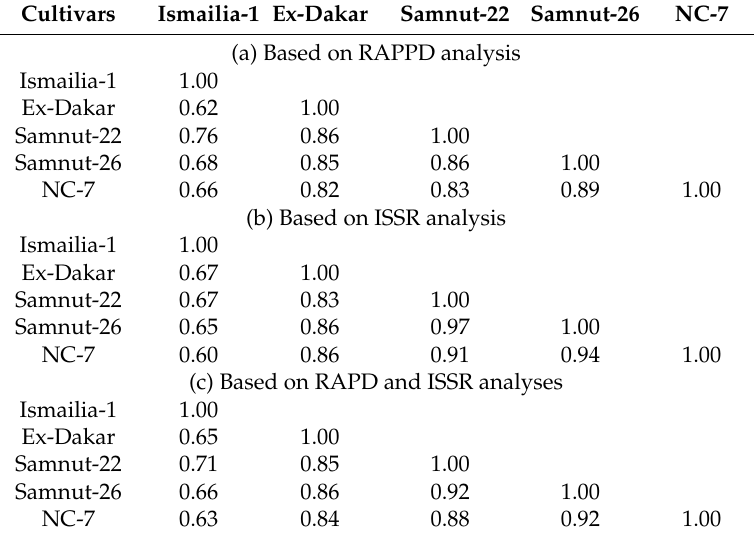
Table 7. Similarity matrices among peanut cultivars according to Jaccard Coe ffi cient based on RAPD and ISSR